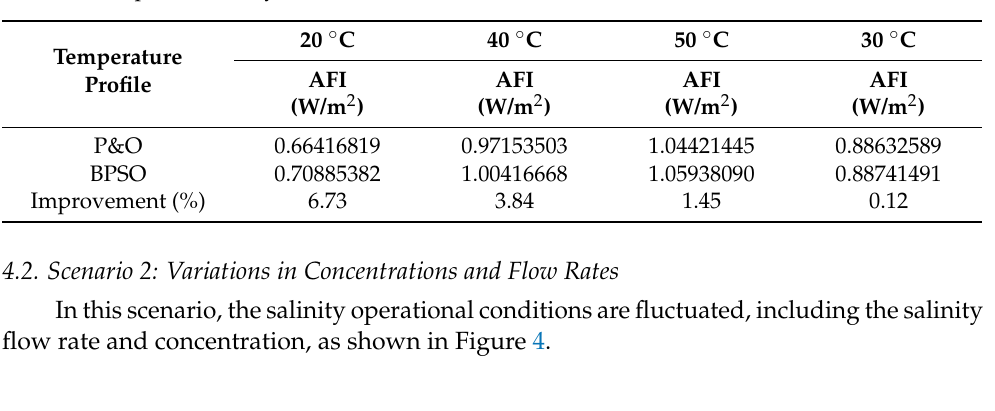
Table 5. Comparative analysis between the BPSO and